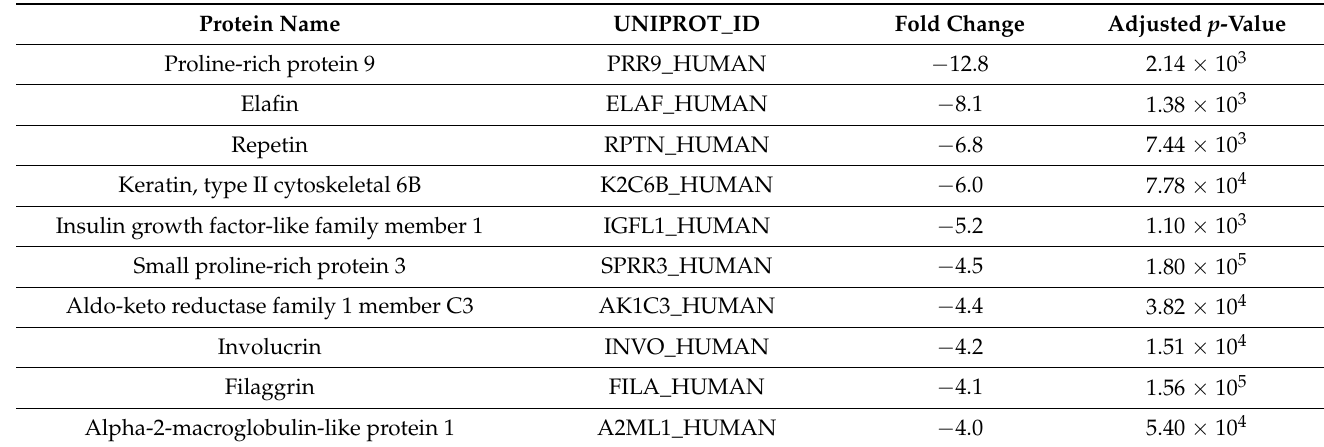
Table 2. List of the top 10 significant proteins most decreased in abundance as measured by mass spectrometry-based shotgun proteomics analysis of HEKn cells expressing HPV16 E6 and E7 com- pared to control